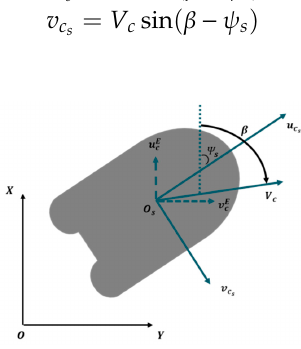
Figure 5. Defined Velocity ( V c ) and direction ( β ) of the current